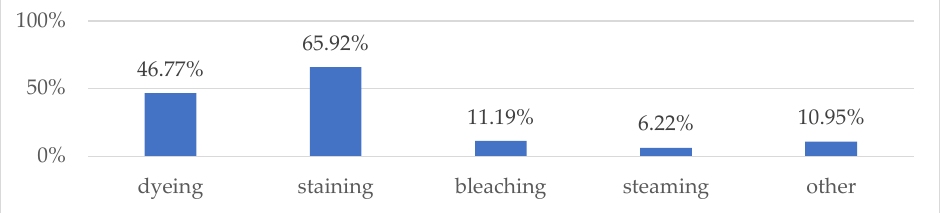
Figure 2. Methods of wood treatment.